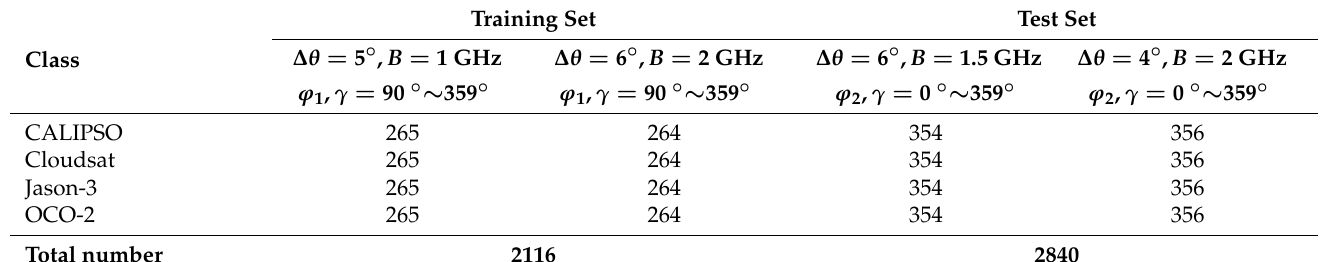
Table 3. Detailed parameter settings of training and test sets for the combined deformation